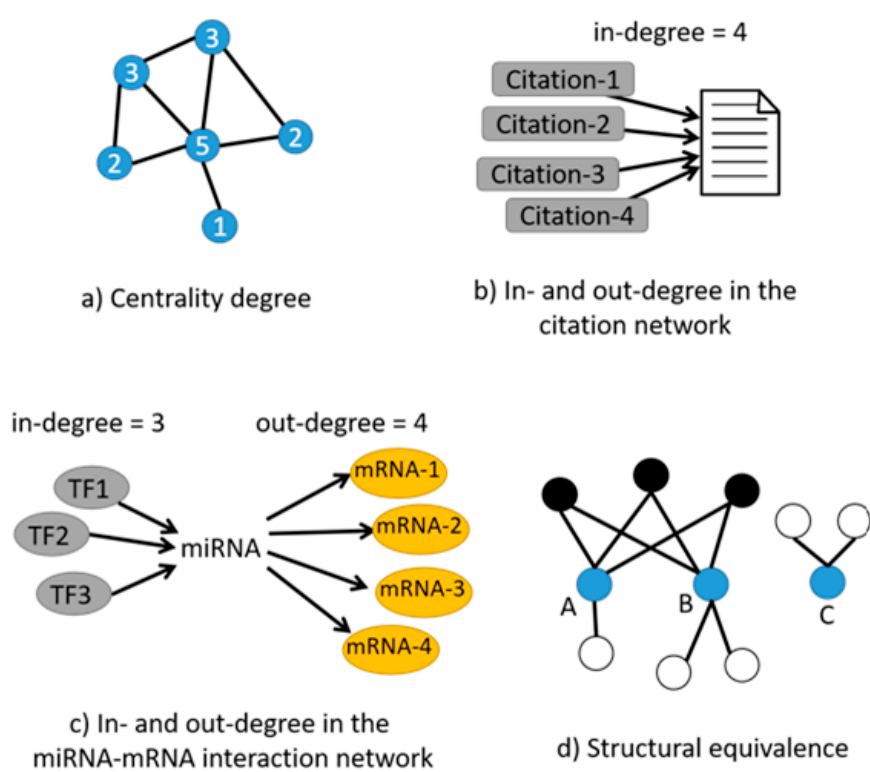
Figure 1. ( a ) The degree of centrality defines the number of edges (black lines) connected to a vertex (blue dots). The number inside the dots represents the centrality degree of each vertex; ( b ) The in- degree of a scientific publication is the number of other papers citing it (citations in grey boxes); ( c ) In a microRNA (miRNA)–messenger RNA (mRNA) interaction network, the number of transcription factors (TF) regulating an miRNA characterizes the in-degree, and the number of mRNA targets of this miRNA for silencing is the out-degree; ( d ) Structural equivalence between 3 vertices, A, B, and C: A and B share, in this case, 3 of the same neighbors (black dots), although both also have other neighbors that are not shared (white dots). Vertex C is not similar to A and B because it does not share any neighbors with them.